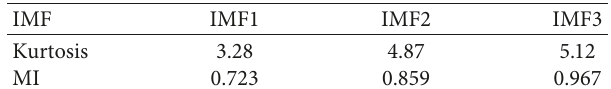
Figure 9: Waveform and spectrum of IMFs by VMD for SFM signal. Table 2: The kurtosis values and mutual information (MI) of IMFs for SFM signal.